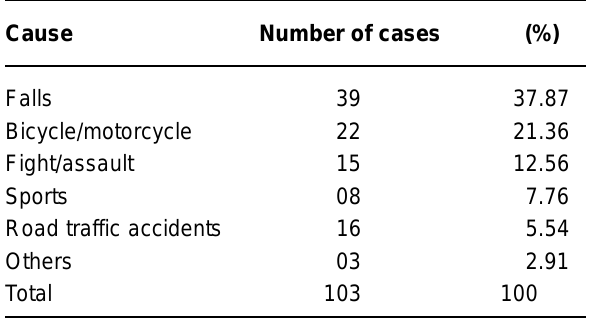
TABLE 2- Analysis of etiologic factors of maxillofacial